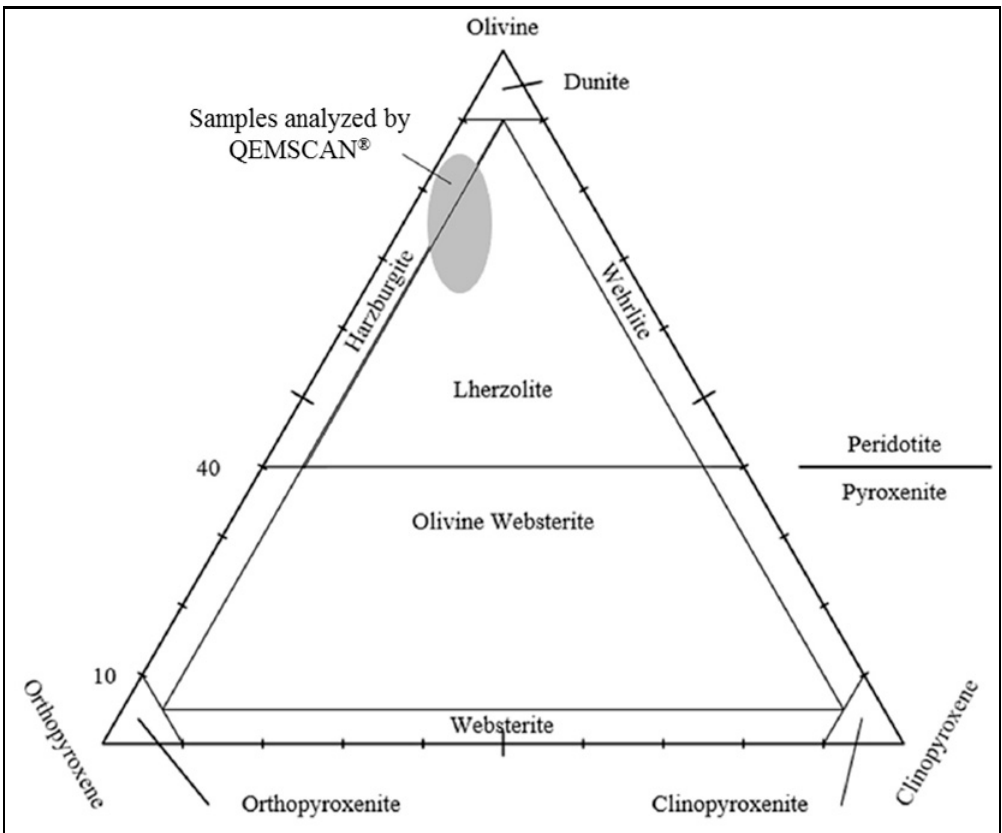
Figure 7. Classification of ultramafic rocks (QAPF) based on the proportion of olivine, orthopyroxene, and clinopyroxene [23].